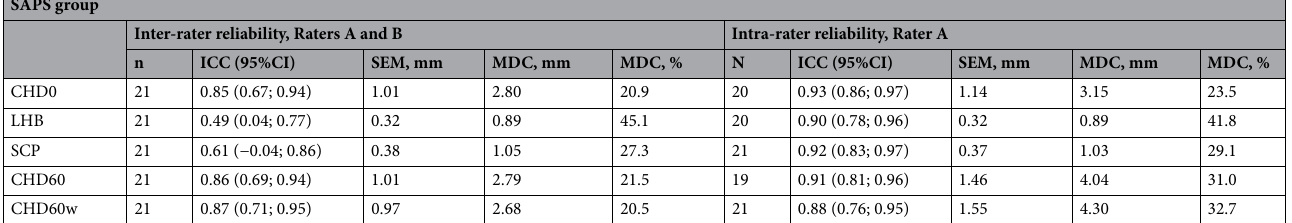
Table 3. Inter and intra rater reliability in the SAPS group. 95%CI 95% confidence interval, CHD0 coracohumeral distance at rest, CHD60 coracohumeral distance at 60°, CHD60W coracohumeral distance at 60° with weights, LHB long head of biceps tendon, MDC minimal detectable change at 95% of confidence interval, MDC% minimal detectable change in % respect to mean value of raters A and B or to three mean values of rater A, n number of participants considered in the statistical analysis, SCP subscapularis tendon, SEM standard error of